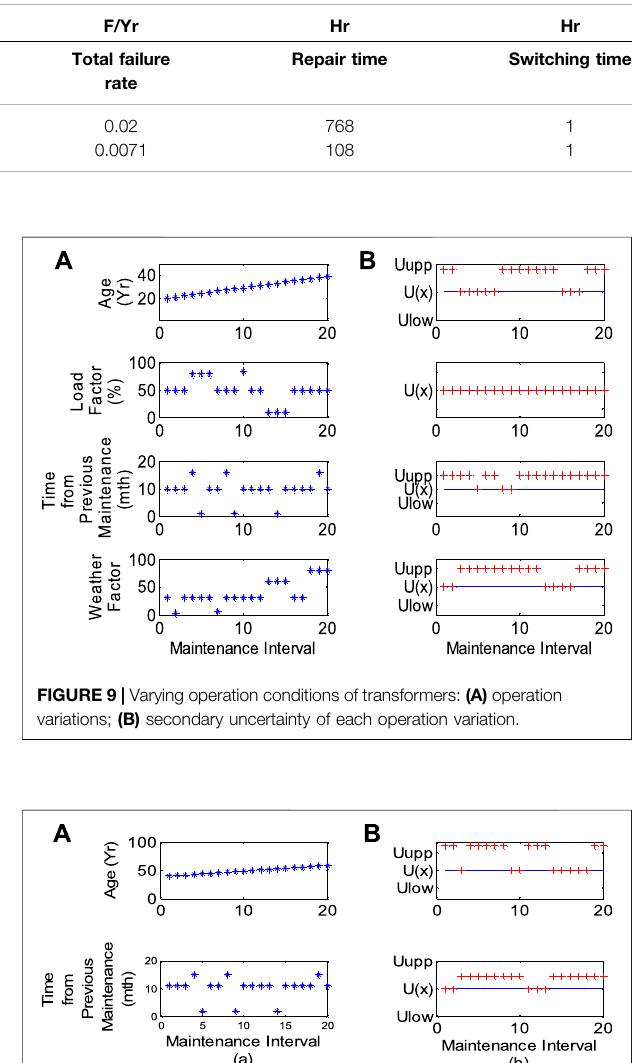
TABLE 2 | Failure data of the transformer and circuit breaker.